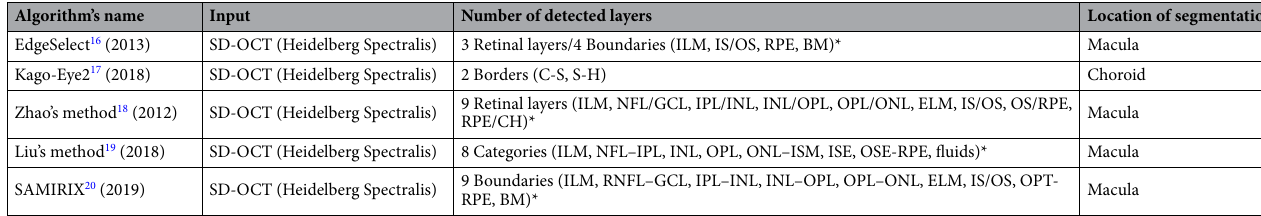
Table 1. Description of the preceding algorithms for OCT semi-automatic layer and fluid segmentation. *Each retinal layer’s abbreviation stands for as follows: ILM inner limiting membrane, NFL nerve fiber